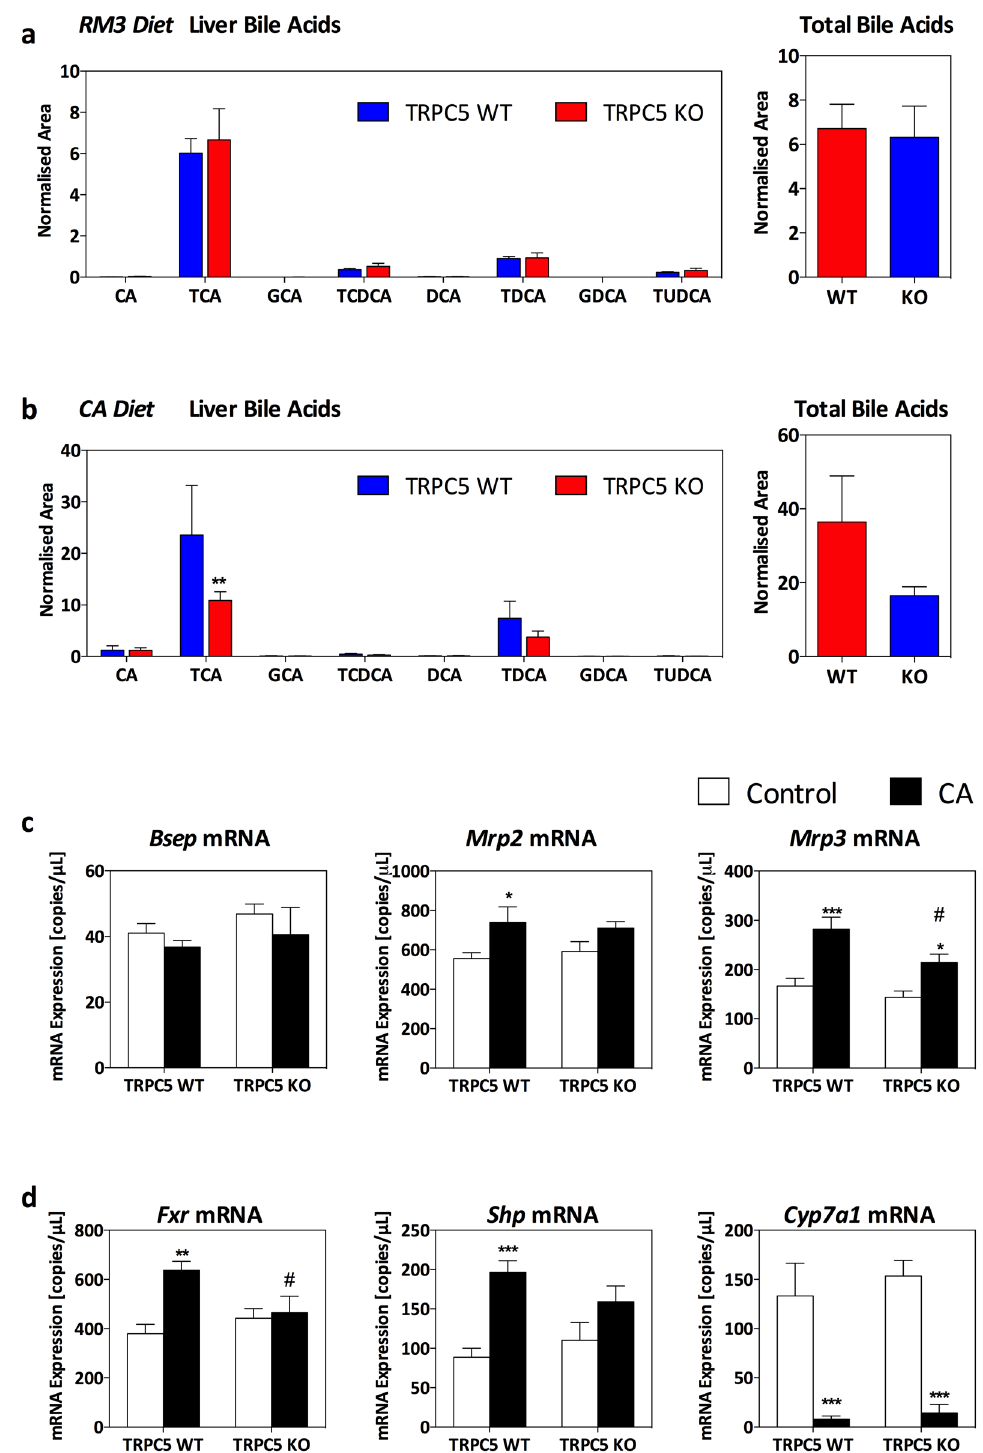
Figure 2. Deletion of TRPC5 attenuates hepatic hypercholanemia. WT and TRPC5 KO mice were fed control (RM3) or CA (0.5% cholic acid supplemented RM3 diet) for 21 days, and ( a ) bile acids were measured in RM3 control diet fed mice and ( b ) CA-diet with respective total bile acids (normalized area). ( c ) Hepatic gene expression determined by real-time quantitative PCR of bile acid transporters, bile salt export pump (Bsep), multidrug resistance-associated protein 2 (Mrp2), and multidrug resistance-associated protein 3 (Mrp3), and bile acid homeostasis/regulatory genes ( d ), farsenoid-X-receptor (Fxr), small heterodimer partner (Shp), and cytochrome P450 family 7 subfamily A member 1 (Cyp7a1), normalized to HPRT, β -actin, and B 2 M. Results are mean ± S.E.M., n = 6–7. * P < 0.05, ** P < 0.01, *** P < 0.001 vs control; # P < 0.05 vs WT CA as determined by two-way ANOVA and Bonferronni Post Hoc